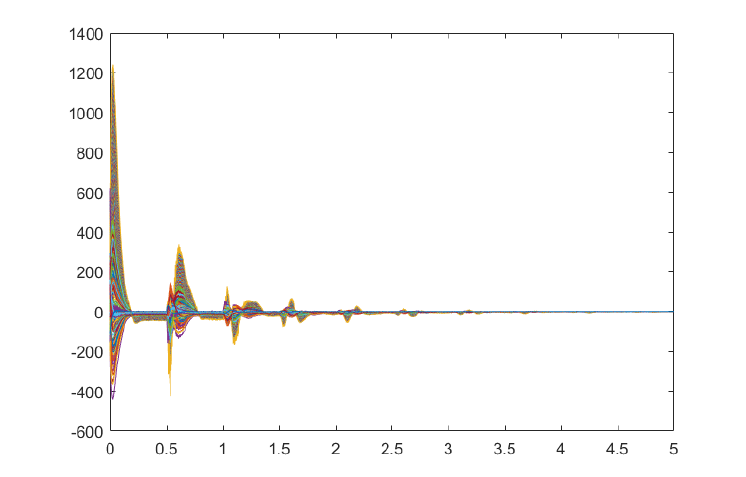
Figure 7. The state trajectories of closed-loop systems with 100 different initial conditions ( x 1 ∈ [ − 200,200 ] , x 2 ∈ [ − 200,200 ]